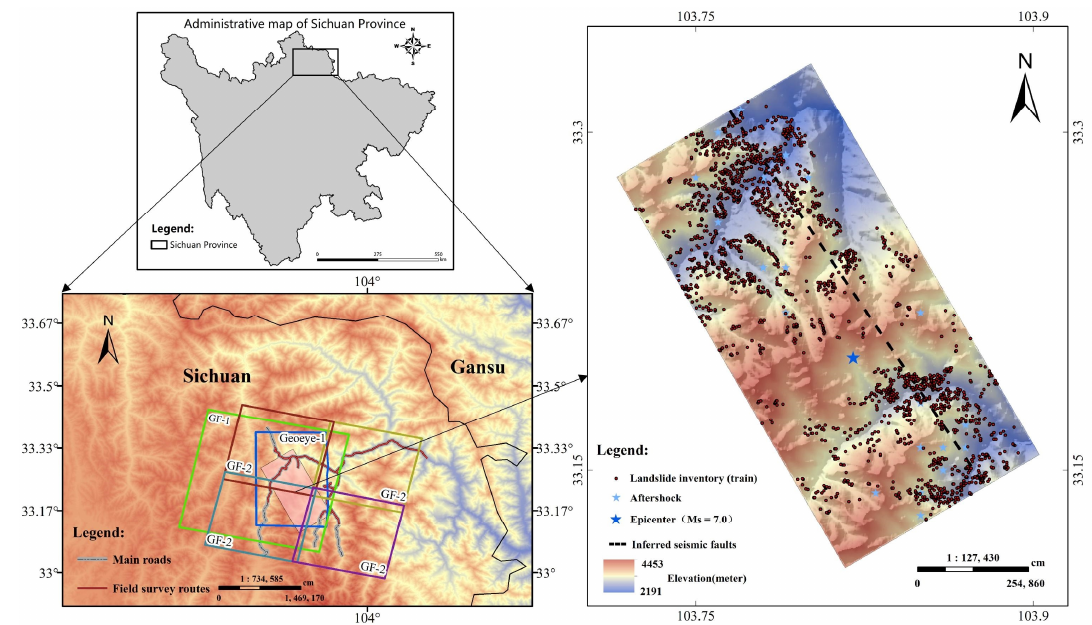
Figure 2. Overview of the study area.